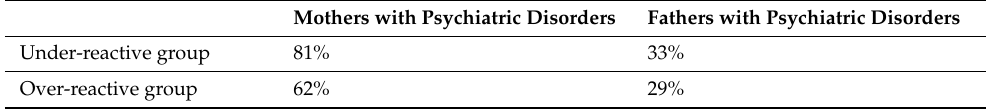
Table 4. Prevalence of parental psychiatric disorders (over-reactive vs. under-reactive